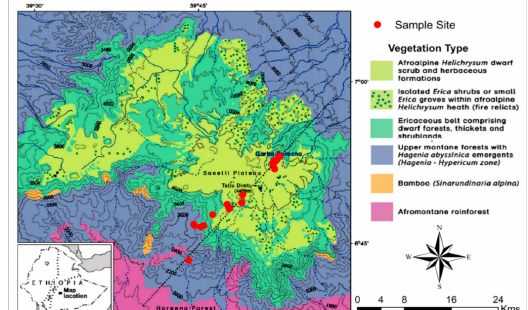
Figure 9. Map of the Bale Mountains showing the vegetation zones and study sites along the Northeast and Southwestern transect (modified after Miehe and Miehe, 1994). Leaves of the dominant vegetation within the Ericaceous and afro-alpine belts were sampled during the dry season in February 2015 and